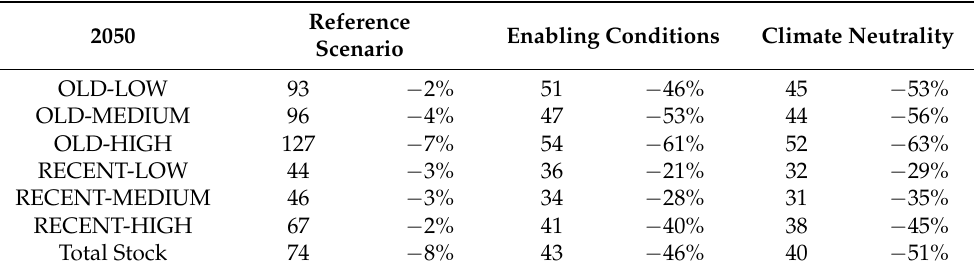
Table 5. Energy consumption for heating and cooling after renovation, avg. in kWh/sqm of the house and in % diff. from the current average